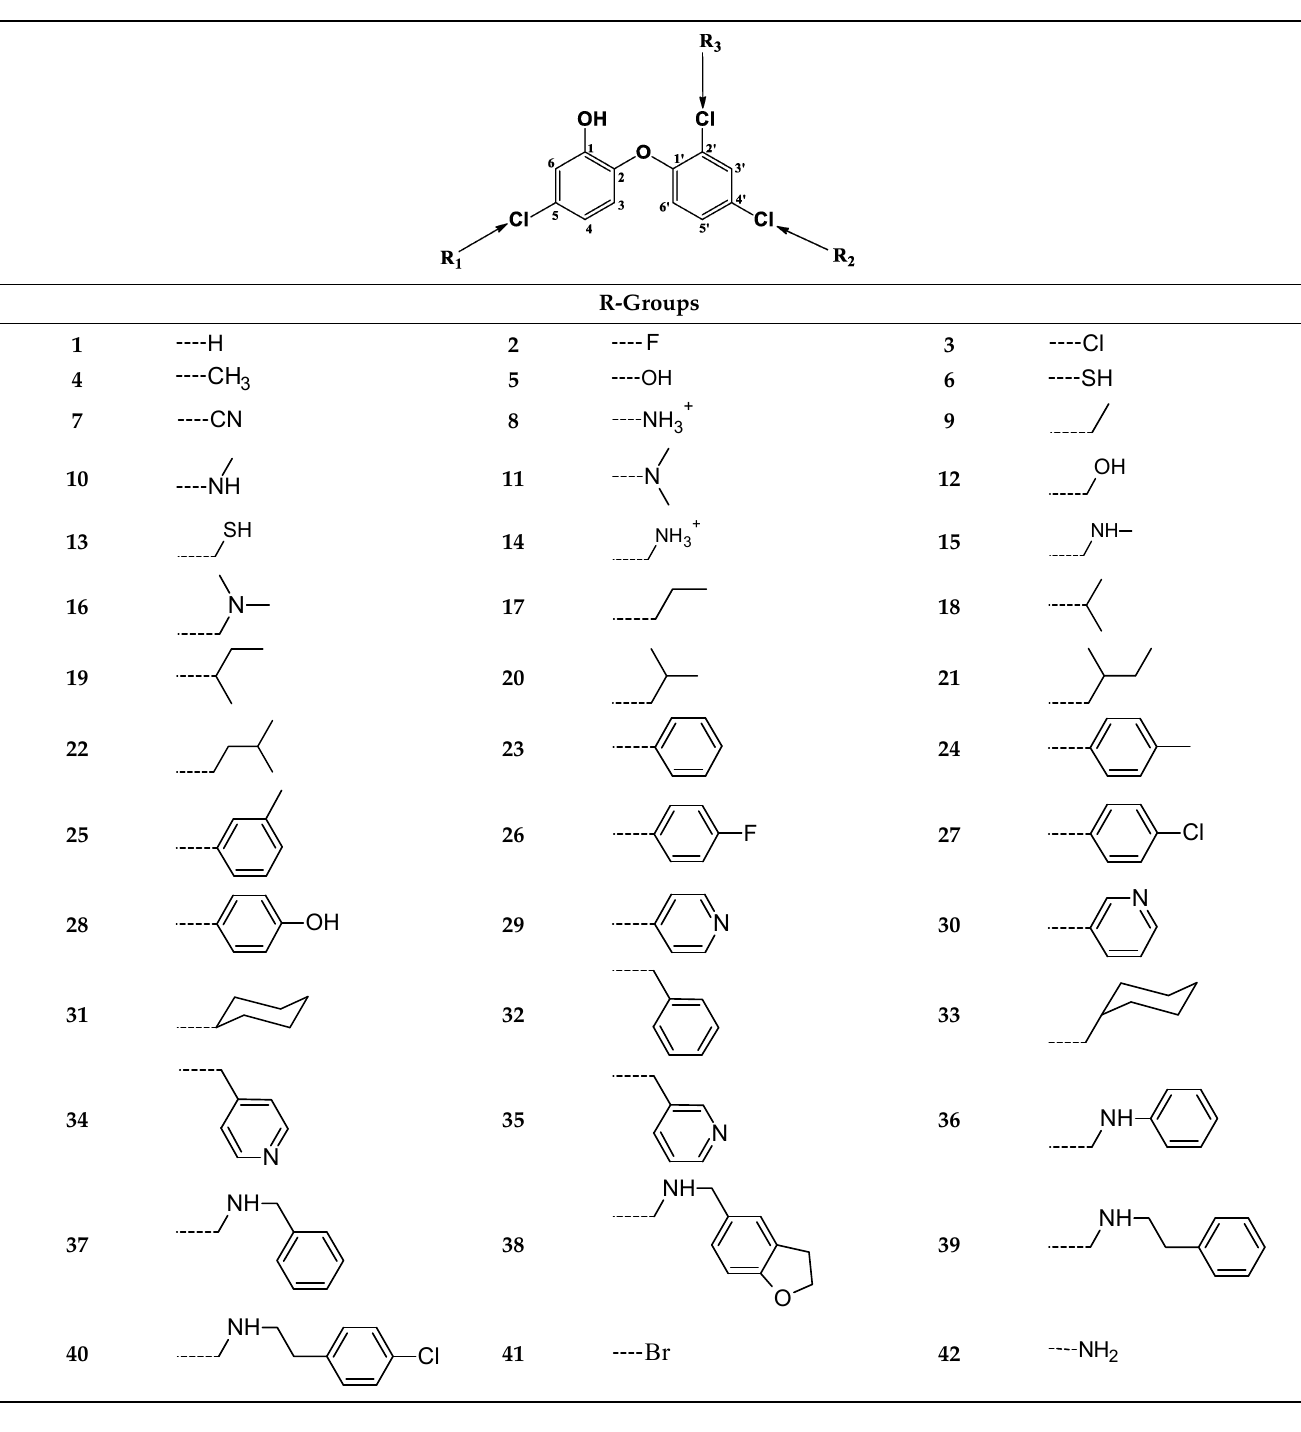
Table 5. R (cid:2869) , R (cid:2870) and R (cid:2871) groups used in the design of the initial diversity library of TCL analogues.